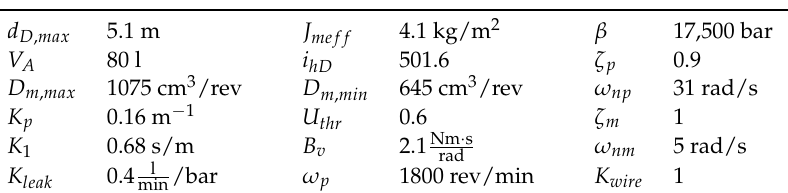
Figure 5. Variation of the motor displacement with all other system parameters fixed. Table 2.